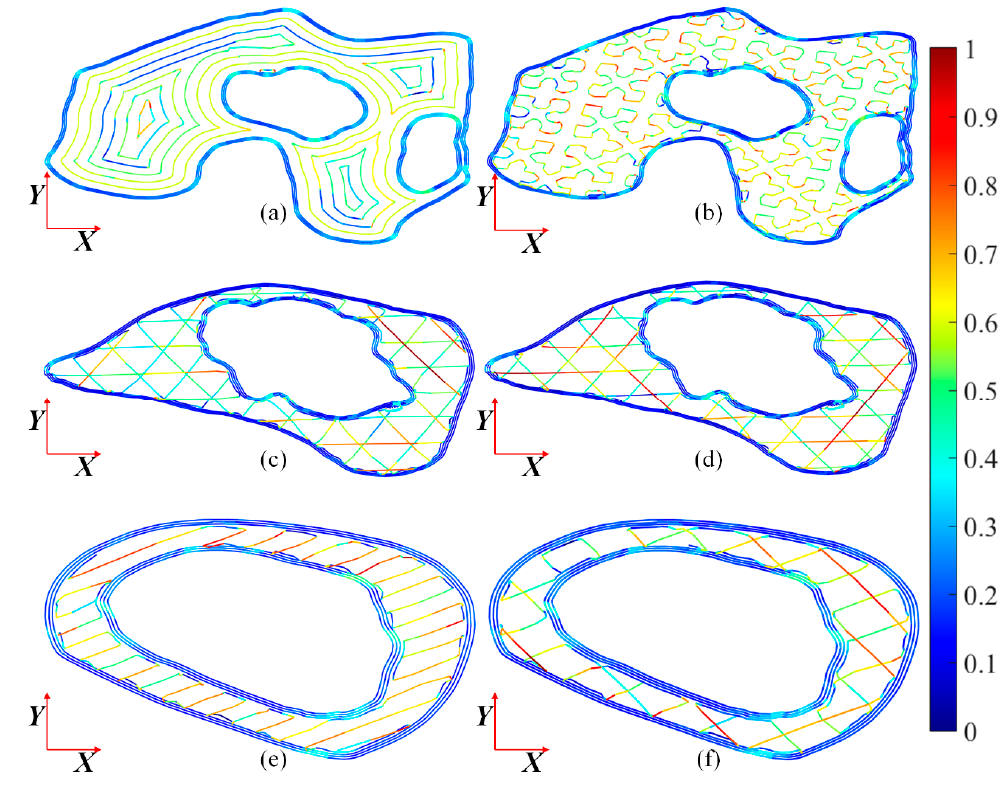
Figure 5. Initialization probability P init of customized layer before defect prediction using convolutional generative adversarial network with incremental h n , where ( a ) is concentric with h n = 0.23; ( b ) is cross with h n = 0.23; ( c ) is triangle with h n = 0.42; ( d ) is tri-hexagon with h n = 0.42; ( e ) is line with h n = 0.73; ( f ) is grid with h n =